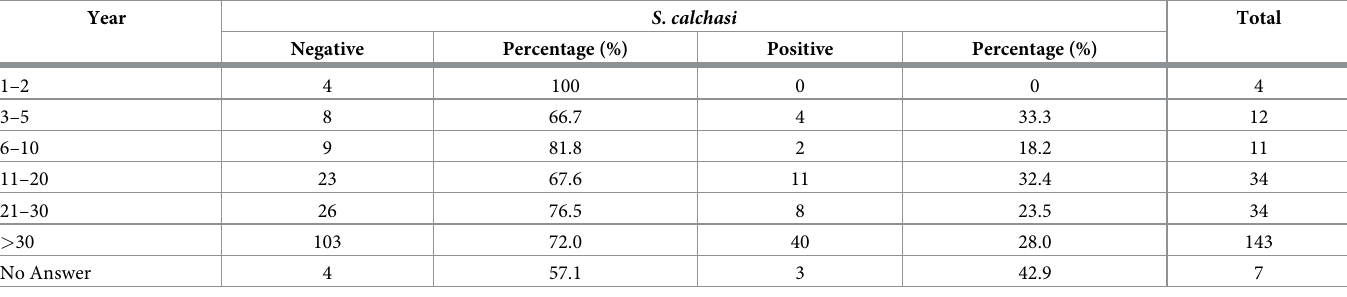
Table 6. Detection of S . calchasi compared with the years of local racing pigeon breeding history. Year S .